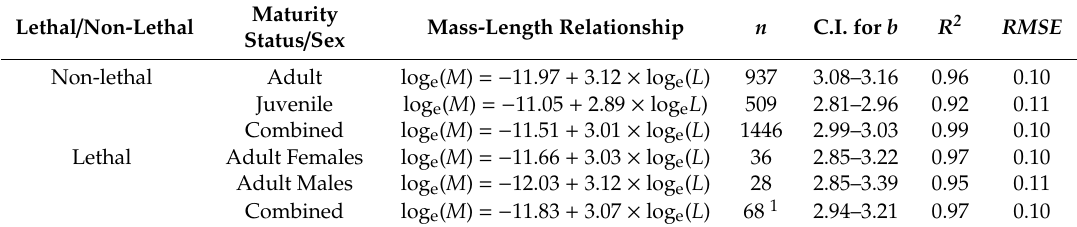
Table 2. Mass-length relationships for lethal and non-lethal samples, and their respective combinations. Coe ffi cients of determination ( R 2 ), root mean square error of the regression ( RMSE ), and the 95% confidence interval (C.I.) for each allometric coe ffi cient ( b ) estimate are provided. Lethal /